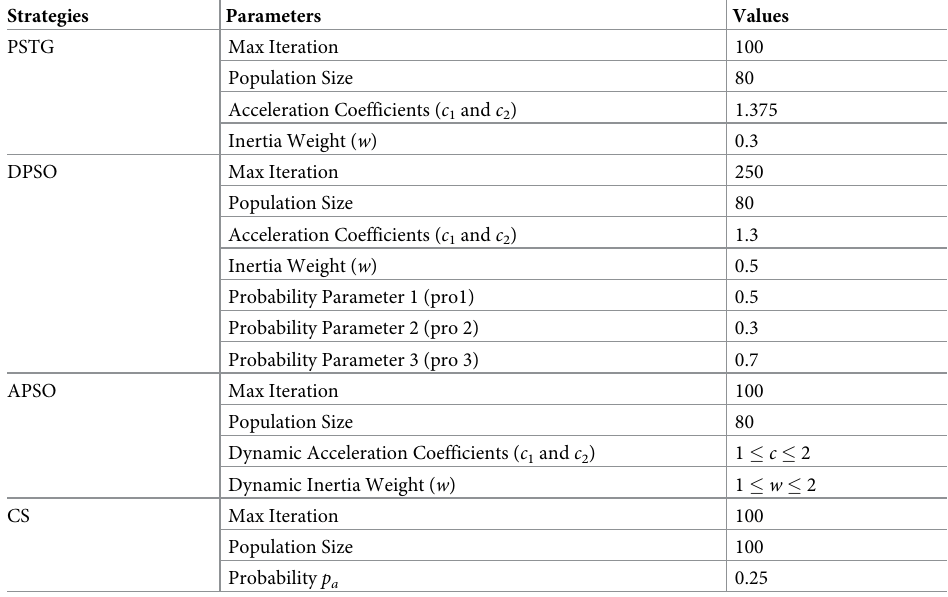
Table 2. Algorithm parameters for strategies of